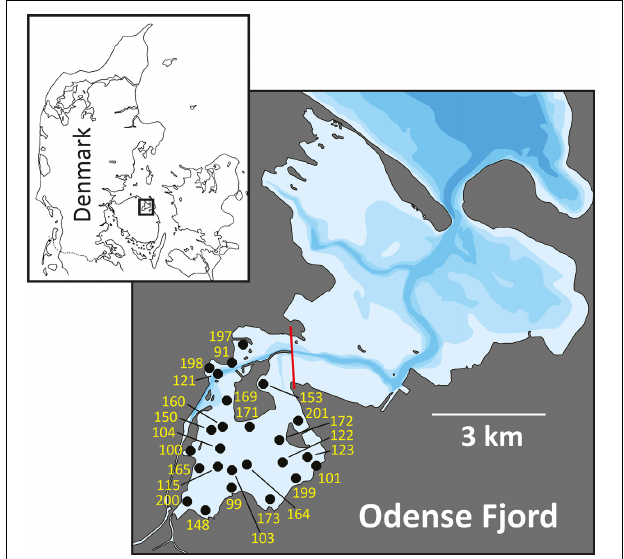
FIGURE 1 | Map of Odense Fjord. The boundary between inner and outer fjord is marked by a red line. All stations used for fauna sampling in the inner fjord are indicated by numbers (excluding the prefix OF).